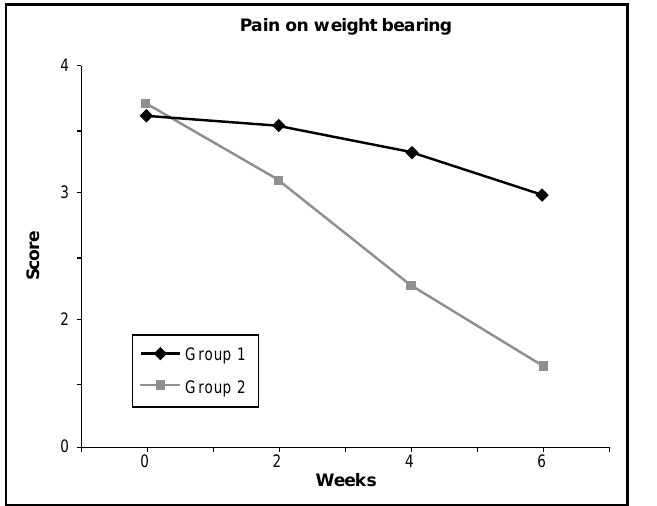
Figure 10: Development of pain on palpation for the six week-course of treatment in the therapy groups.